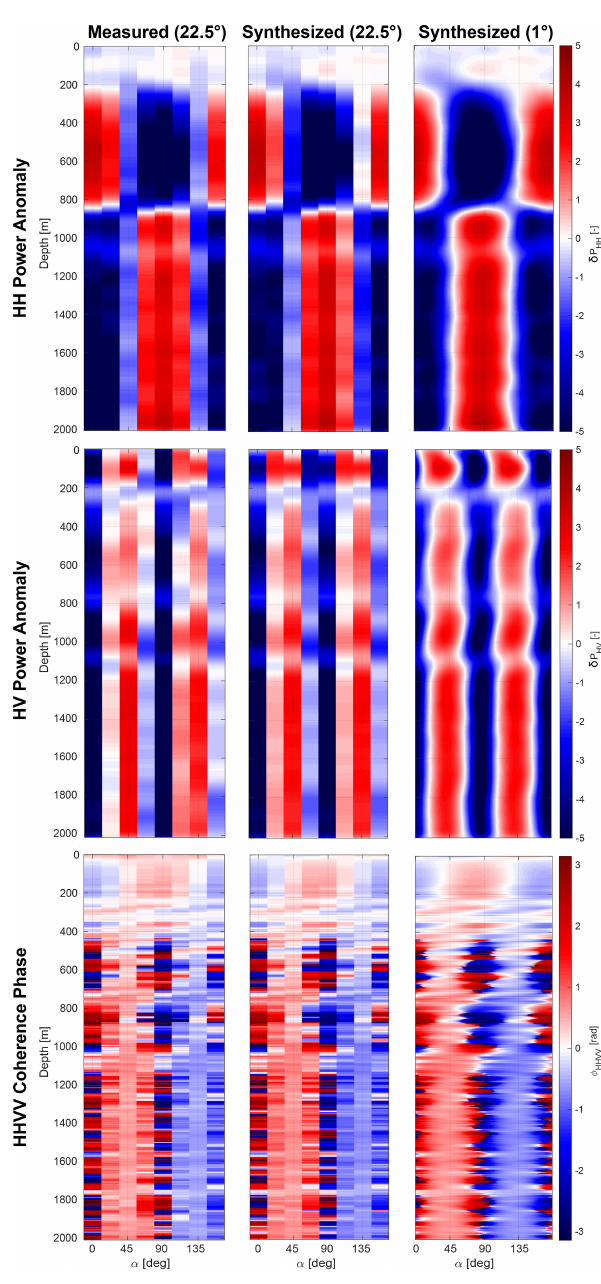
Figure E1. Comparison between measured and synthesized ApRES data at the EDML site. Left column: measured ApRES data (22.5 ◦ azimuthal spacing). Middle column: synthesized ApRES data (22.5 ◦ azimuthal spacing). Right column: synthesized ApRES data (1 ◦ azimuthal